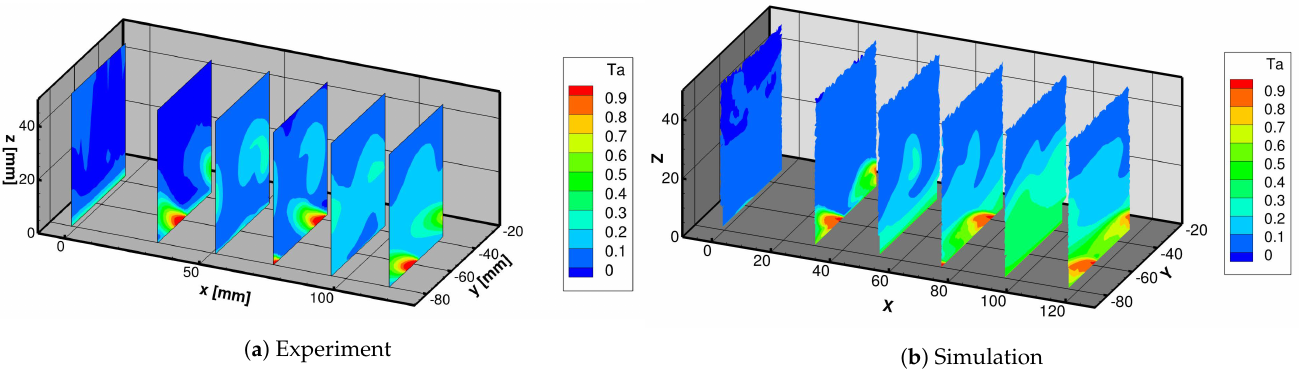
Figure 20. Experimental and numerical non-dimensional temperature field (constant-X planes).